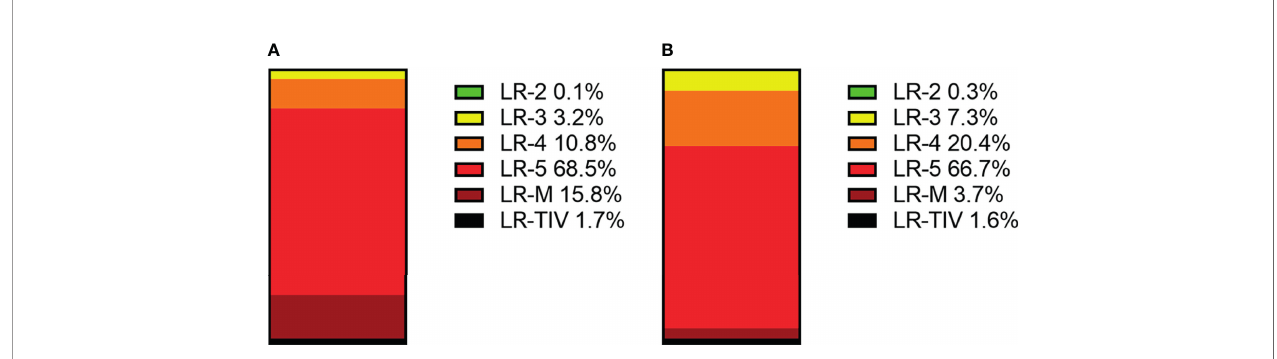
FIGURE 3 | Distributions of HCCs in each CEUS category (A) and CT/MRI category